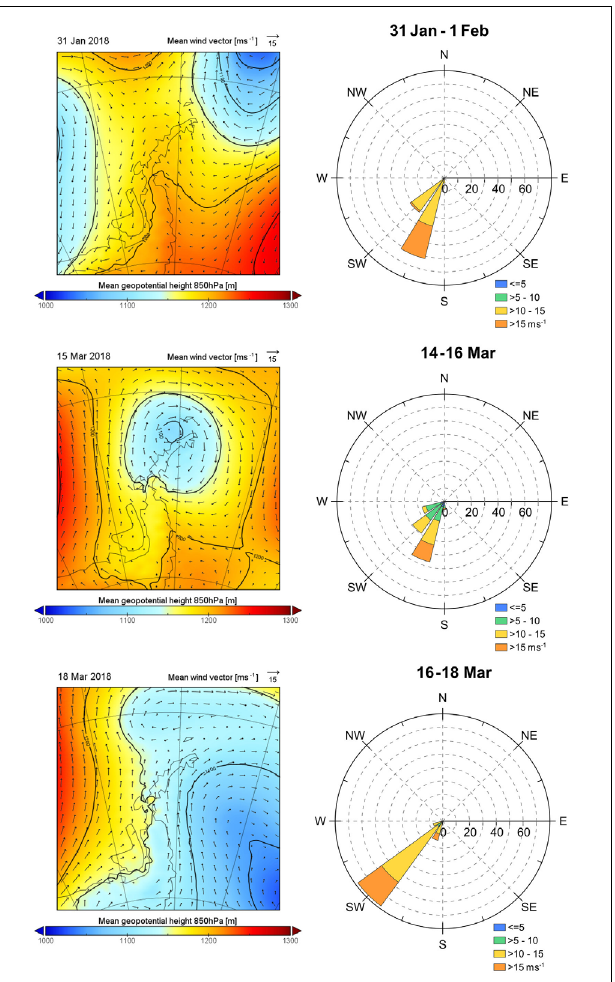
FIGURE 7 | Synoptic situation over the Antarctic Peninsula, wind roses for all three major dust